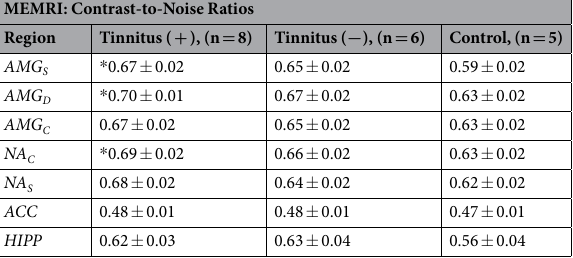
MEMRI: Contrast-to-Noise Ratios